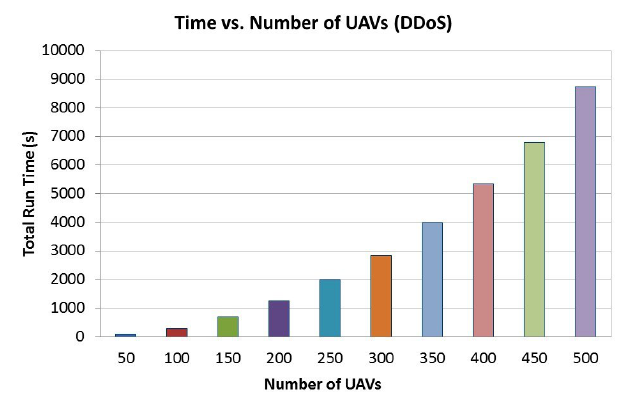
Figure 3. Run time variation with number of attack nodes for DDoS